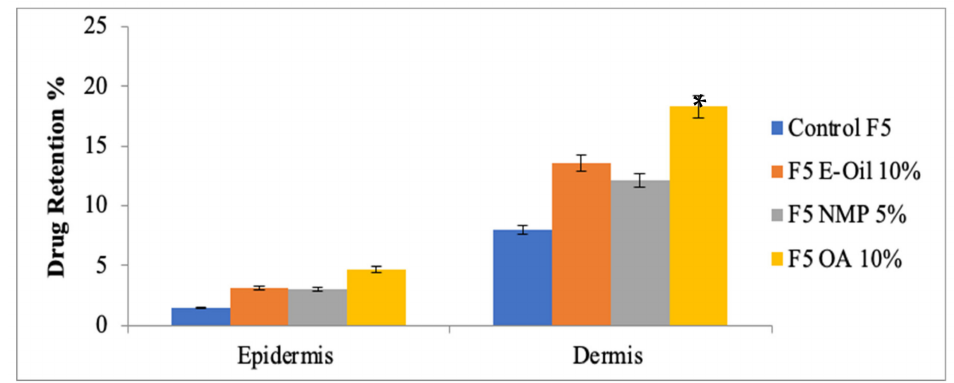
Figure 10. Skin drug retention analysis of optimized MTX patches with optimized concentrations of penetration enhancer. One-way ANOVA followed by post hoc Tukey test ( p < 0.05). Data are expressed as mean ± SD; n = 3. (* p